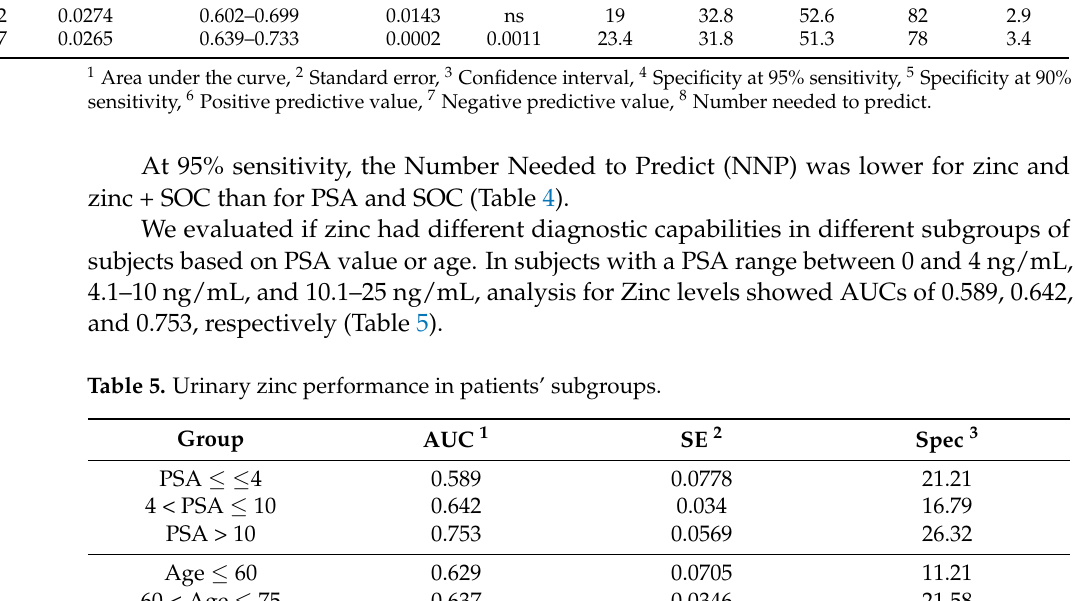
Table 4. Diagnostic models and accuracy.